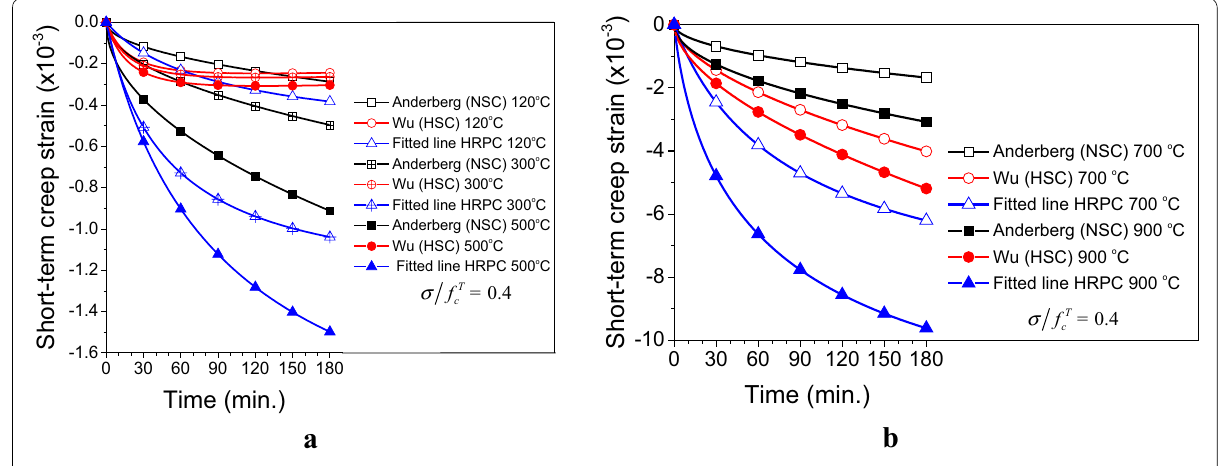
Fig. 9 Comparison of STC of HRPC with NSC and HSC at a 120–500 °C and b 700–900